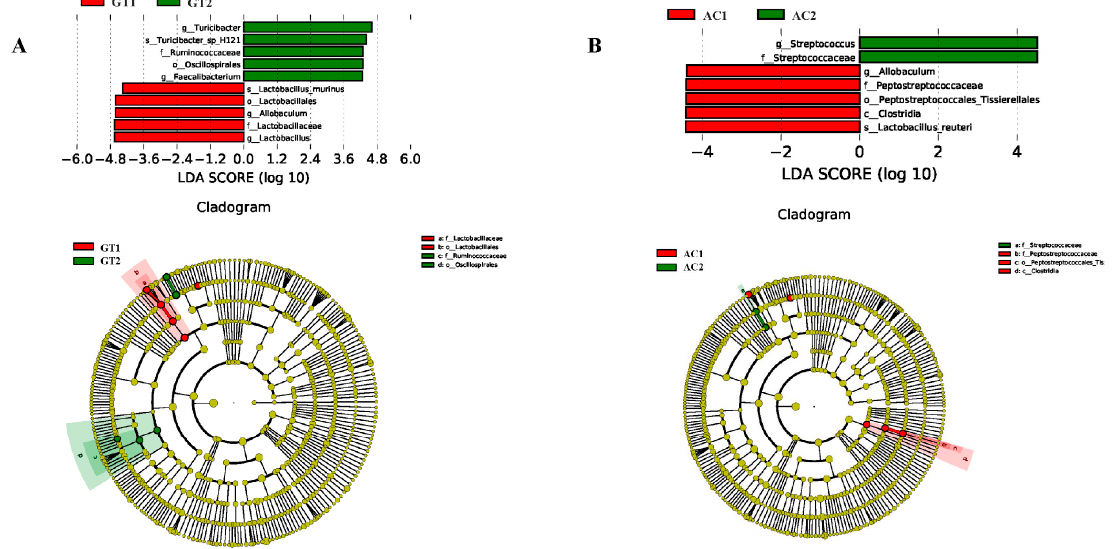
Figure 5. LEfSe analysis identified fecal bacteria of GT ( A ) and AC ( B ) groups. The histogram of the LDA score shows that the abundance of species differed significantly between different groups. The LDA score represents the size of the effect. In the cladogram, the circles radiating from the inside to the outside represent the classification level from the phylum to the genus (species). The diameter of each circle is proportional to the relative abundance of taxa. Red nodes refer to the bacteria that contributed greatly in GT1 or AC1, whereas green nodes refer to the bacteria dominant in GT2 or AC2. GT1, before gradual transition, n = 6; GT2, after gradual transition, n = 6; AC1, before abrupt change, n = 7; AC2, after abrupt change, n = 7.